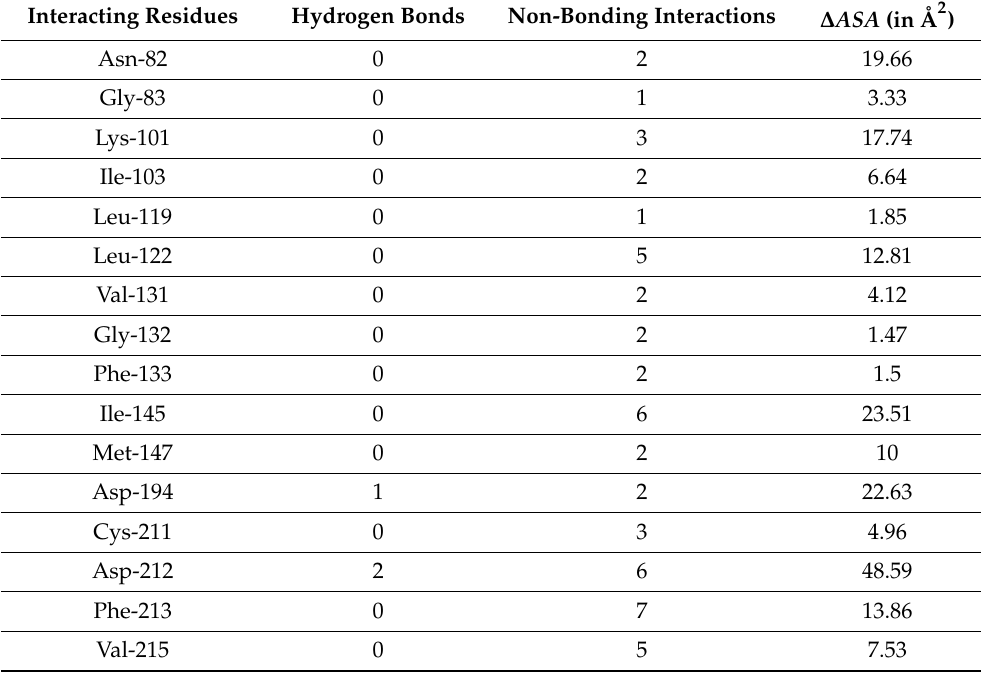
Table A1. The MEK2 residues interacting with selected flavonoid M2F1 are listed with the number of non-bonding interactions and ∆ ASA